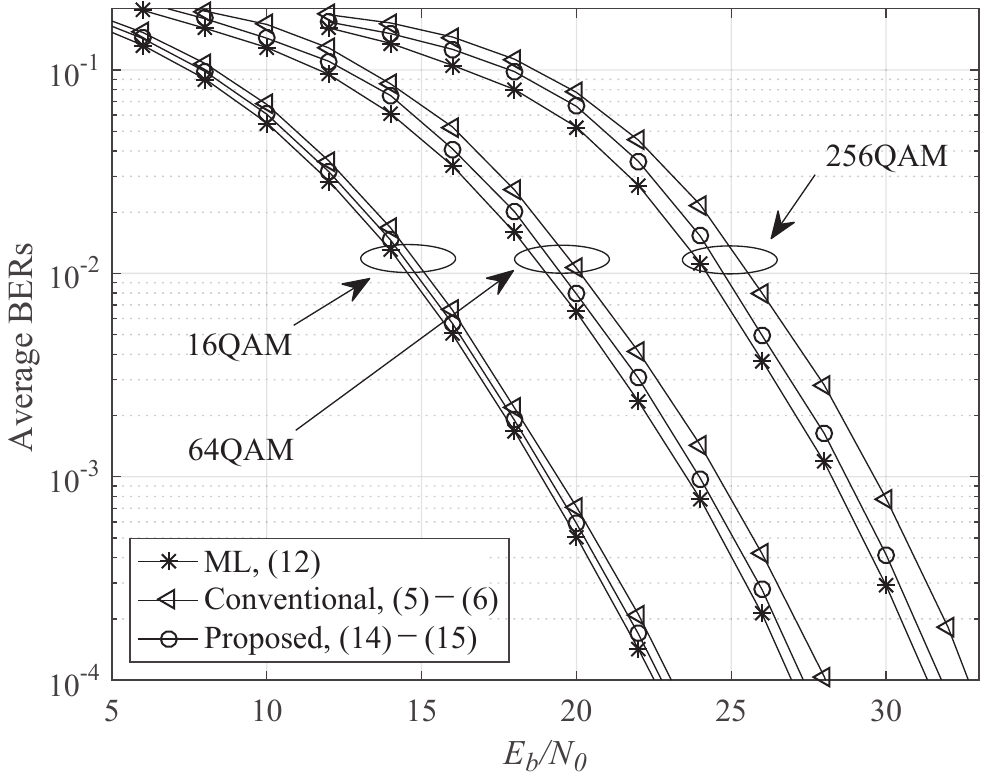
Figure 3. Average BERs for the QO-DSTM [8] with Θ R